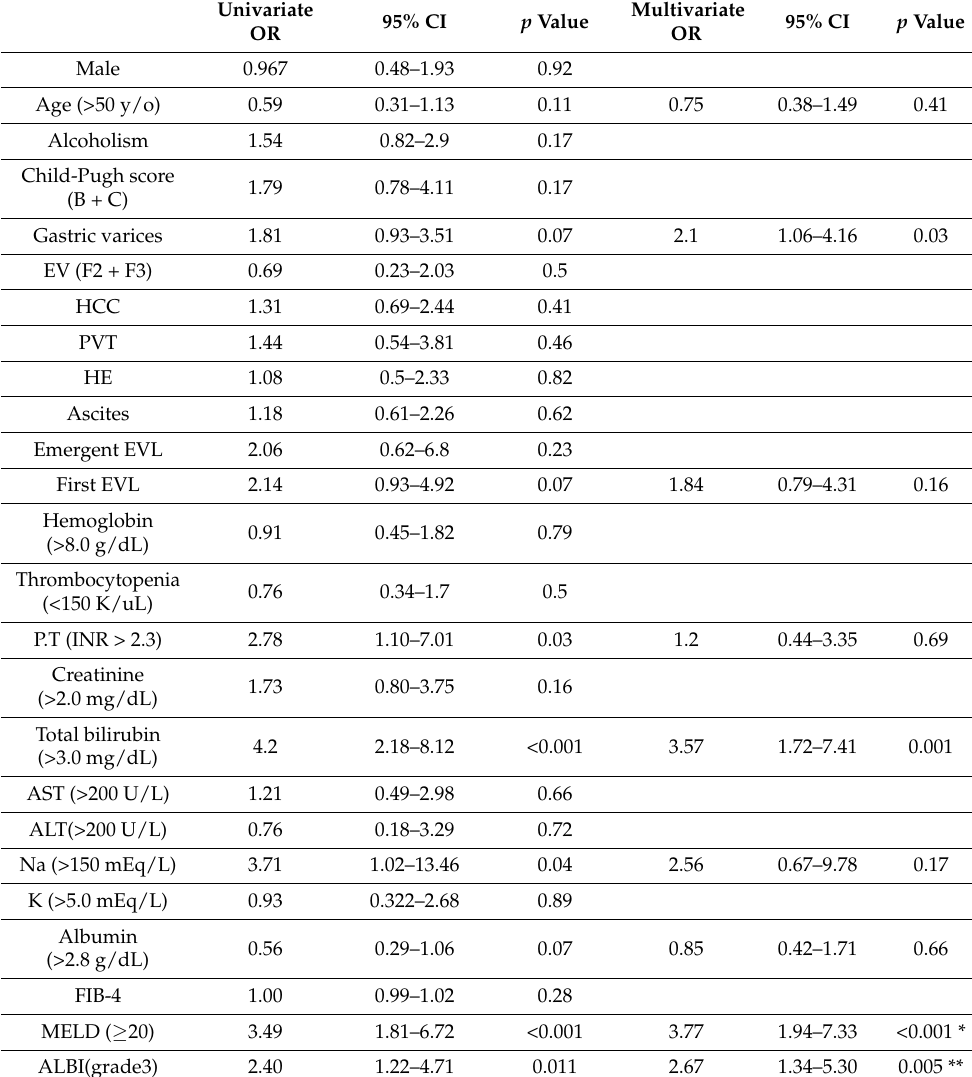
Table 2. Logistic regression analysis for delayed PBUB